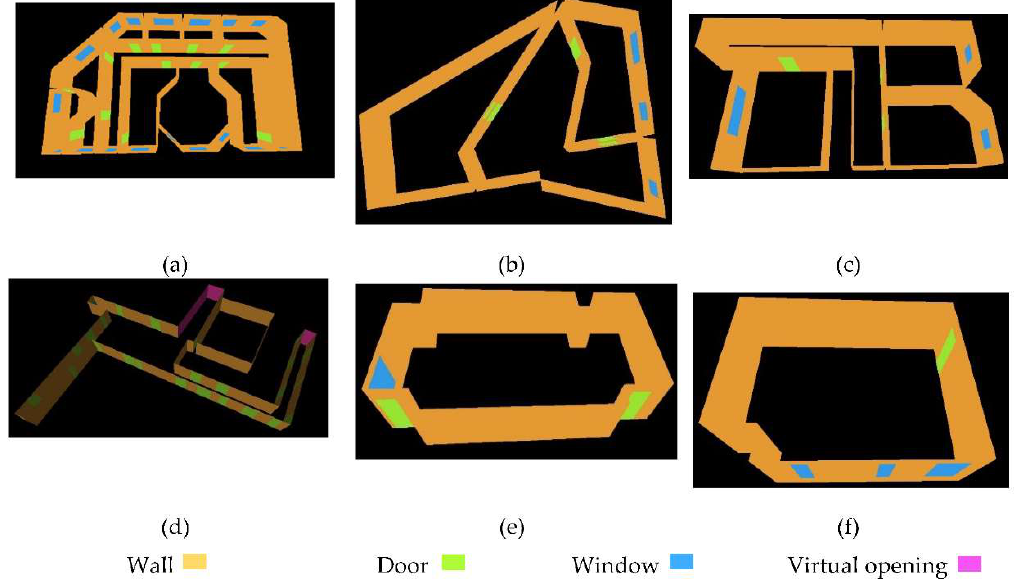
Figure 10. Visualization of reconstructed models from ( a – c ) synthetic datasets and ( d – f ) BLS datasets